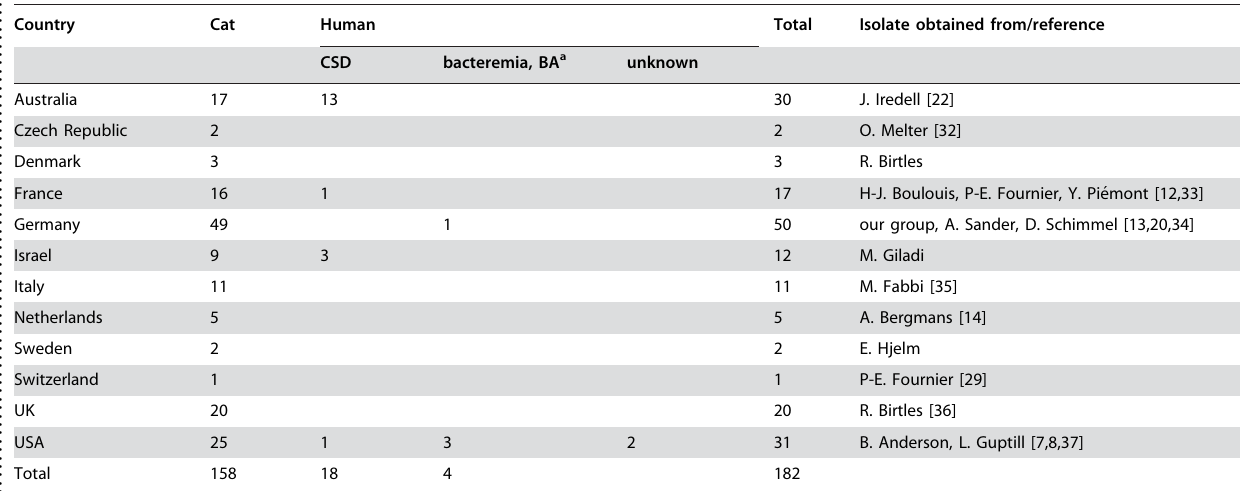
Table 4. Geographic origin, host species and clinical source of B. henselae isolates. .. ... .... ... ... .... ... ... .... ... ... .... ... ... .... ... ... .... ... ... .... ... ... .... ... ... .... ... ... .... ... ... .... ... ... .... ... ... .... ... ... .... ... ...